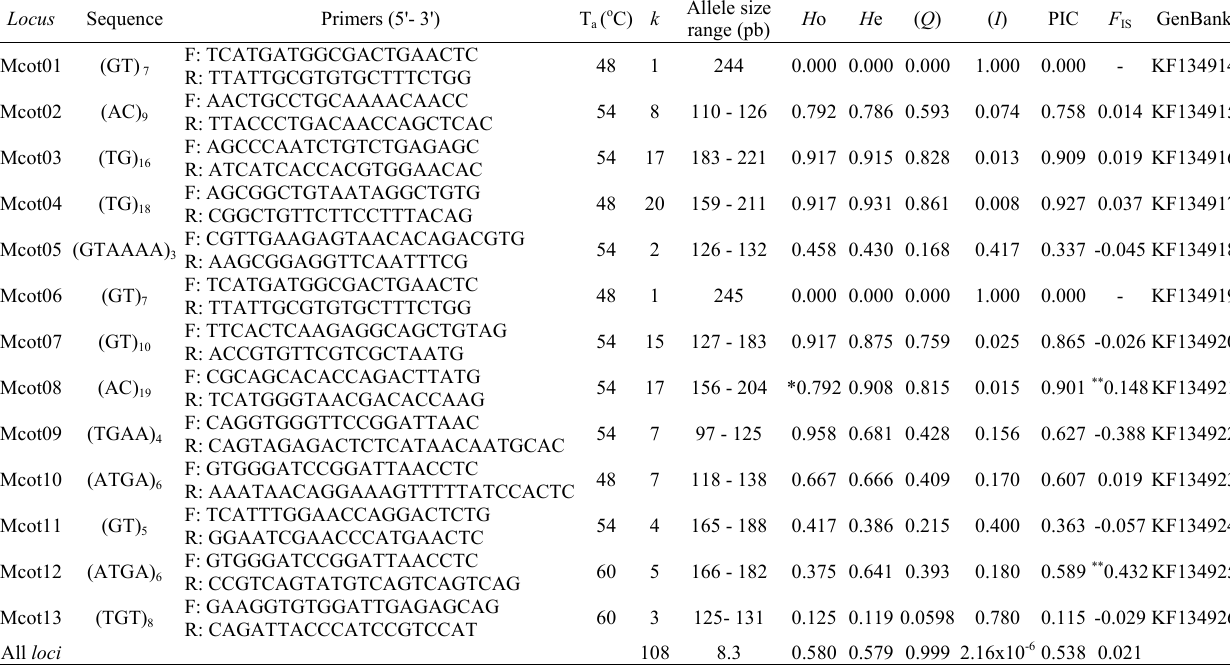
Table 1. Description of 13 microsatellite loci (11 polymorphic and two monomorphic) isolated from the Neotropical fish Microglanis cottoides . Flanking primers, T = optimal annealing temperatures, k = number of alleles, allele size range (bp), H a heterozigosity, H = expected heterozygosity estimated from 30 individuals, Q = paternity exclusion probability, I = probability of e genetic identity, F = endogamy coefficient, PIC = polymorphic information content, GenBank accession numbers. * Significant IS deviations from Hardy-Weinberg equilibrium (P < 0.05). ** Significant value for the endogamy coefficient ( F